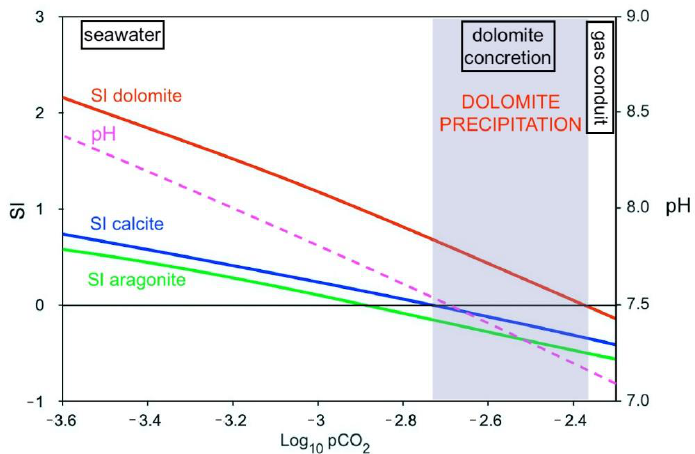
Figure 10. Variations of dolomite, calcite, and aragonite saturation indexes (SI) and pH, as a function of Log 10 pCO 2 . SI values higher than 0 indicate supersaturation, and values lower than 0 indicate undersaturation.